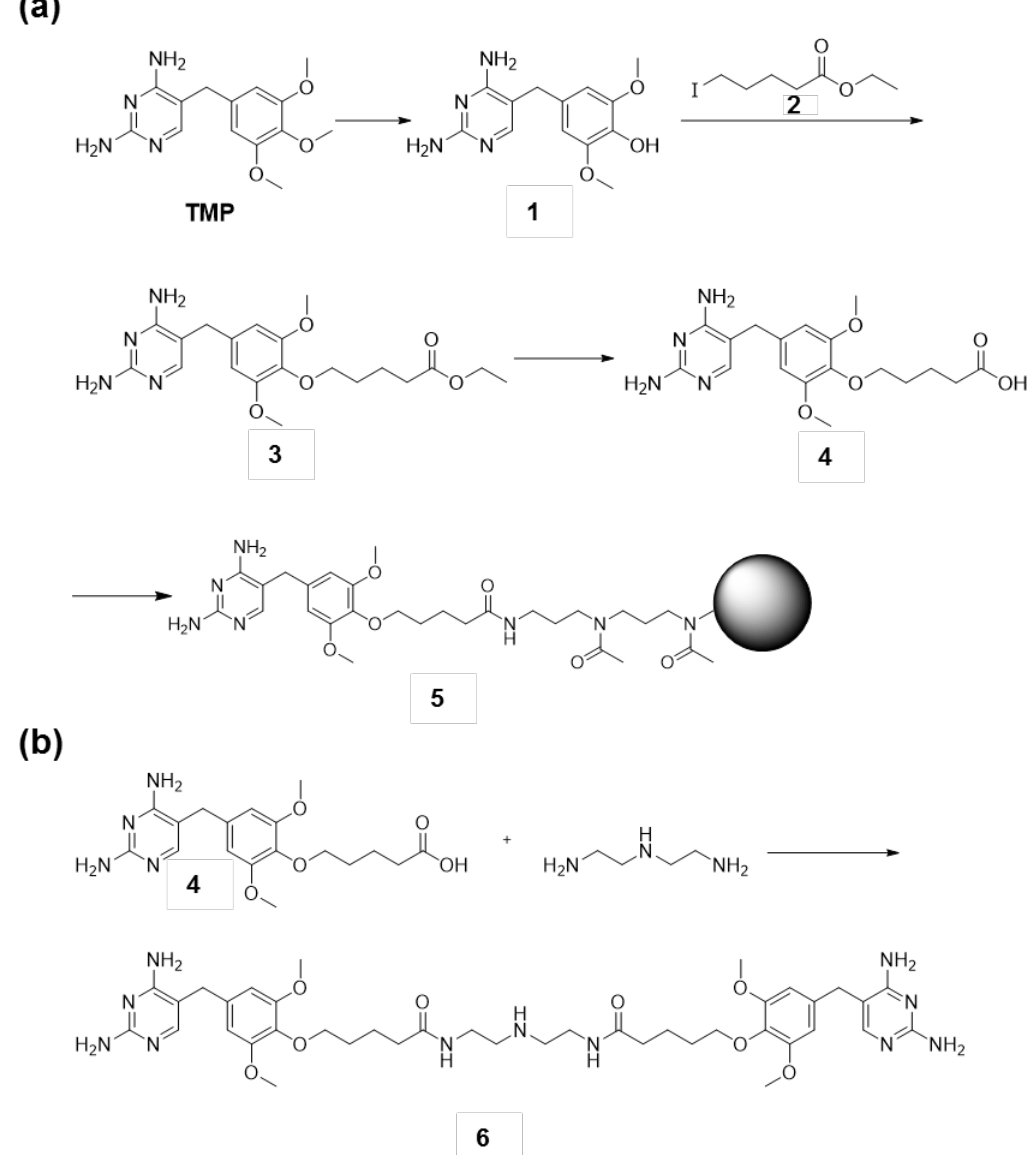
Figure 2. Preparation of derivatives of trimethoprim (TMP). ( a ) Reaction scheme for the preparation of TMP covalently coupled to agarose beads; ( b ) Reaction scheme for the preparation of a TMP dimer.